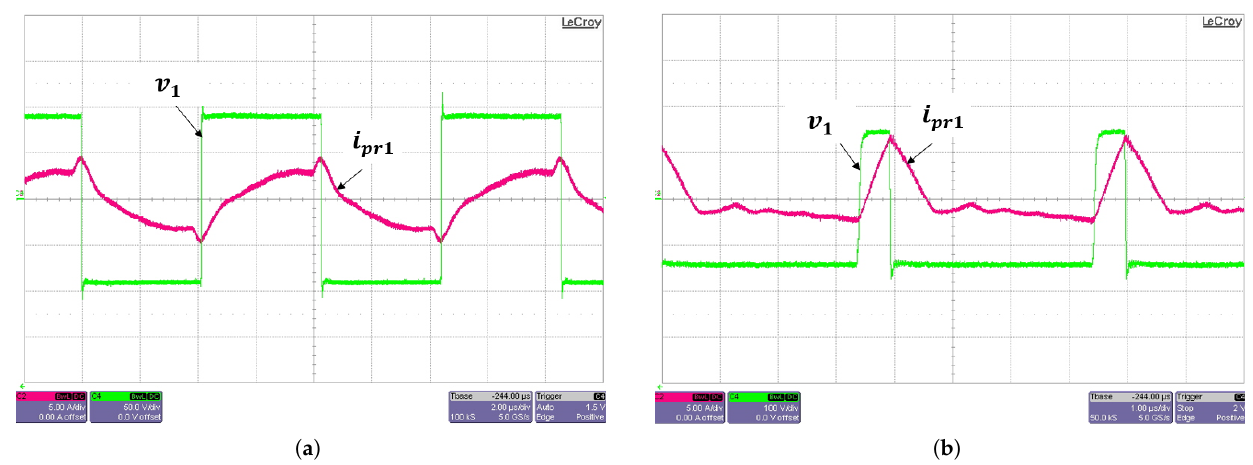
Figure 20. Experimental waveforms at 10% load condition in single-phase operation at ( a ) Voltage across resonant tank v 1 (50 V/div) and primary current i pr 1 (5 A/div) at V in = 90 V ( b ) Voltage across resonant tank v 1 (100 V/div) and primary current i pr 1 (5 A/div) at V in = 160 V.